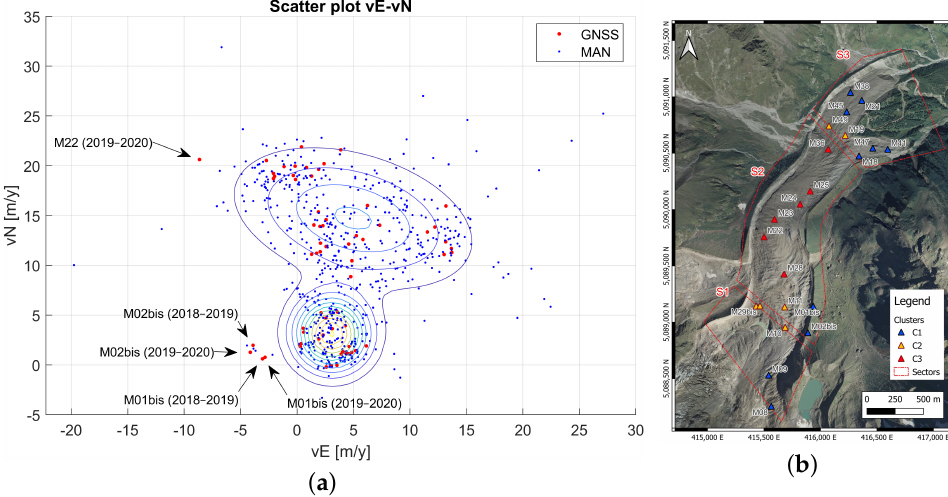
Figure 6. ( a ) Scatter plot of the planimetric components (vE-vN) of GNSS and MAN velocity vectors obtained from all the years; ( b ) Location of the moving GNSS